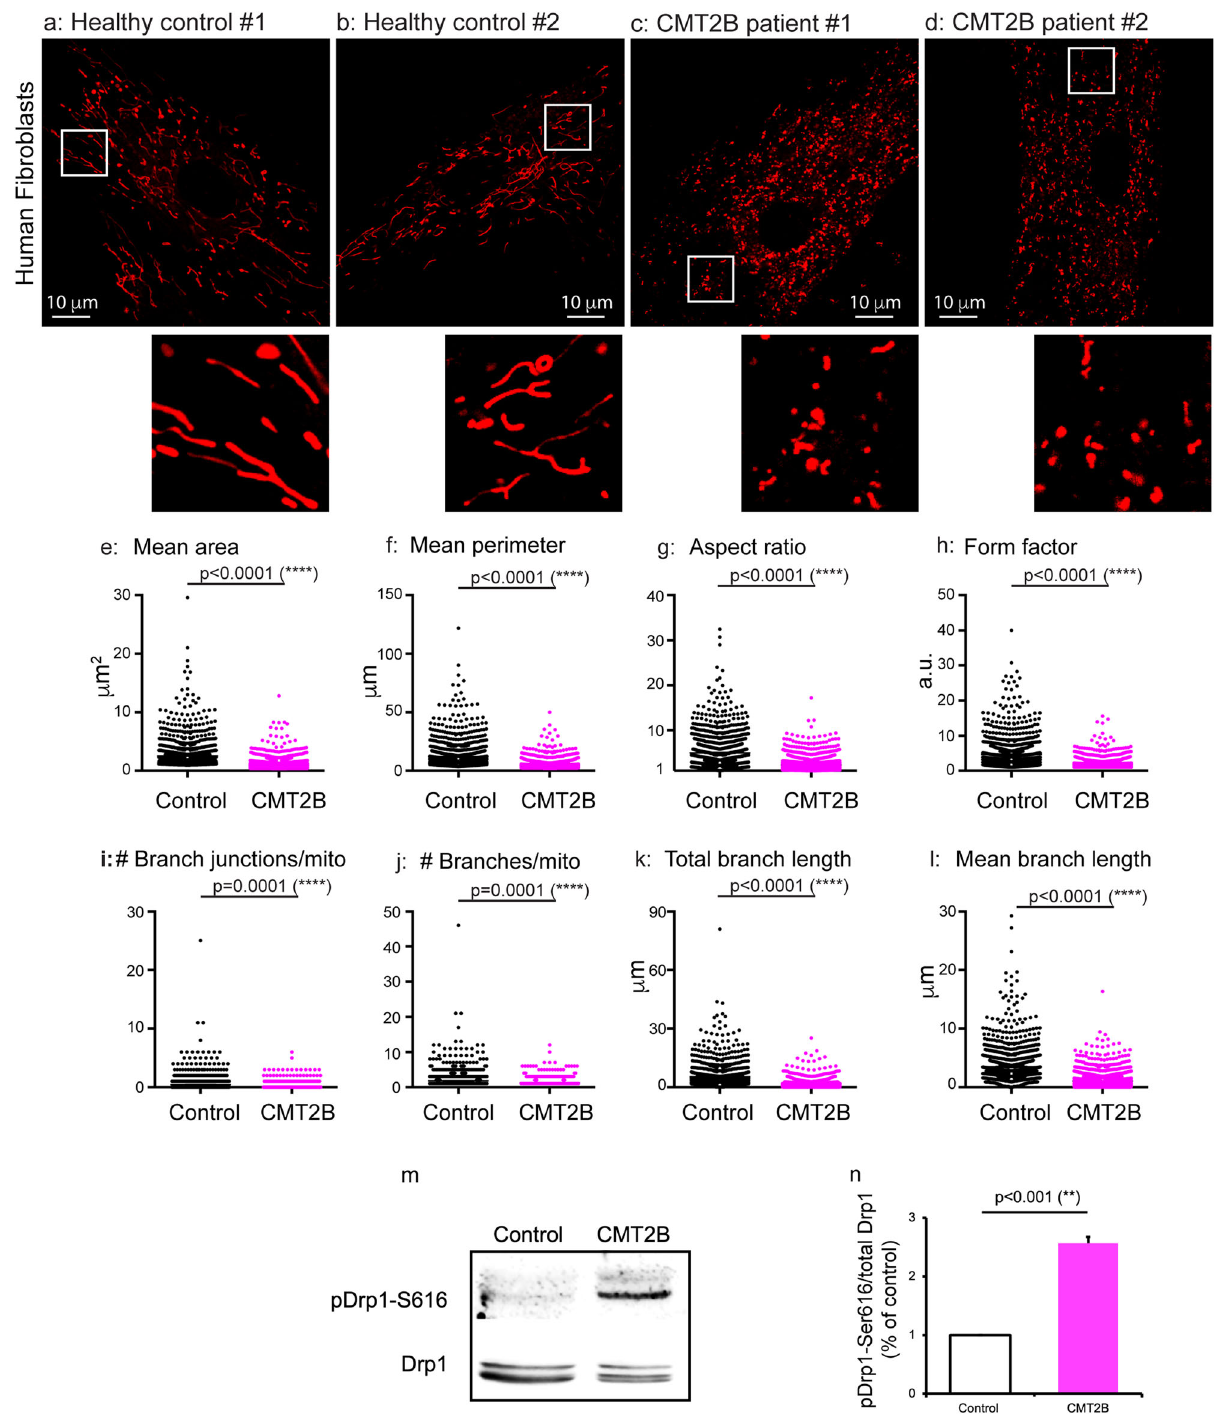
(Fig. 1e) and perimeter (5.608 ± 0.767 µm versus 12.1 ± 0.857 µm for healthy controls) (Fig. 1f). In addition, both AR, the aspect ratio (2.717 ± 0.258 versus 5.092 ± 0.3 for healthy controls) (Fig. 1g) and the form factor (2.153 ± 0.261 versus 4.626 ± 0.291 for